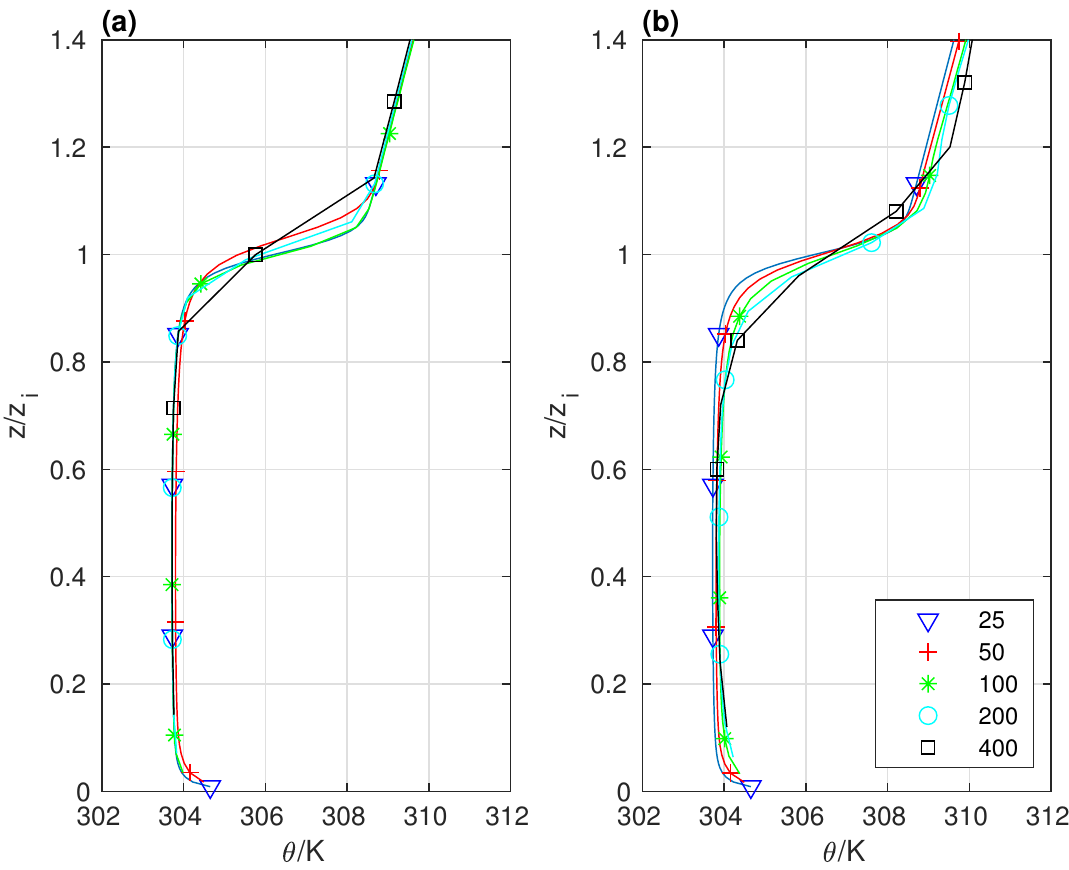
Figure 5. Domain-averaged potential temperature profiles from CBL2 runs ( a ) for a 25 m grid length and coarse grained to other grids and ( b ) at different native grid spacings. Each line is for a different coarse graining scale ( a ) or for a simulation with a different grid length ( b ), the values in m being indicated in the